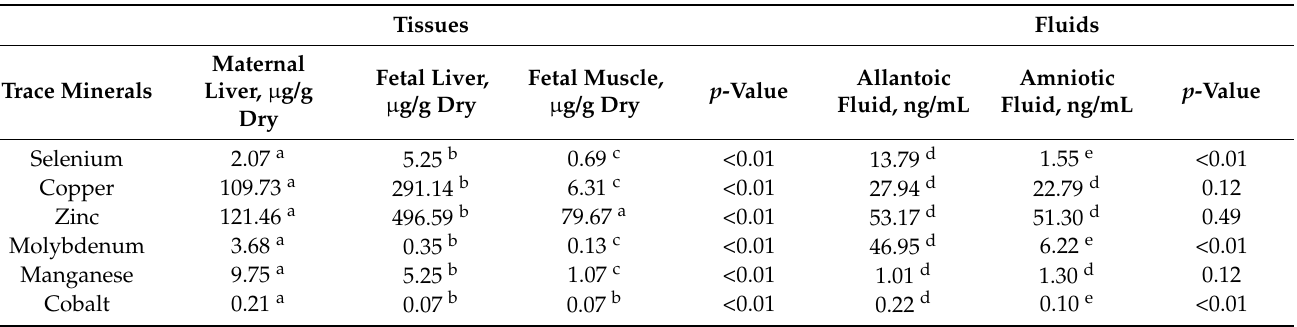
Table 8. Abundance of trace minerals in maternal liver, fetal liver, fetal muscle, allantoic fluid and amniotic fluid of beef heifers on d 83 of gestation 1